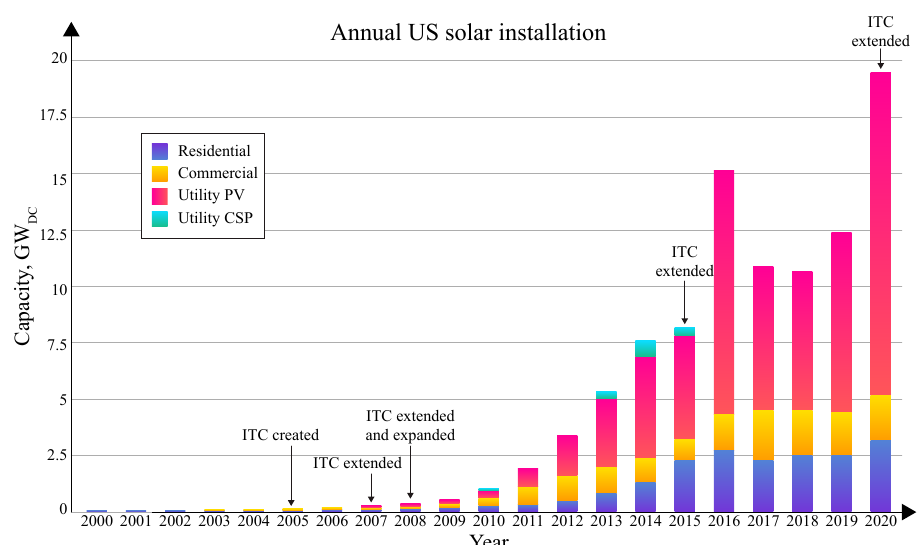
Figure 22. Impact of ITC on the growth of the solar industry in the United States. Significant impact observed in 2016, when the ITC extension of 2015 resulted in the highest recorded solar additions and held the record for several years to come